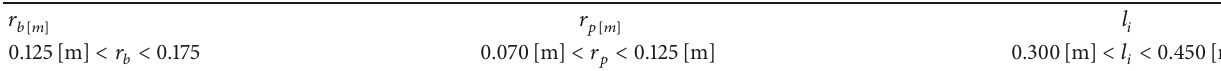
Table 5: Constraints for three-variable optimization of the